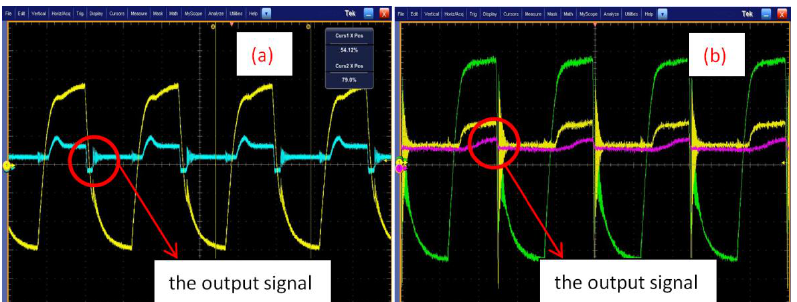
Figure 6. The the output signal. ( a ) MOSFET is normal; ( b ) MOSFET is degraded.